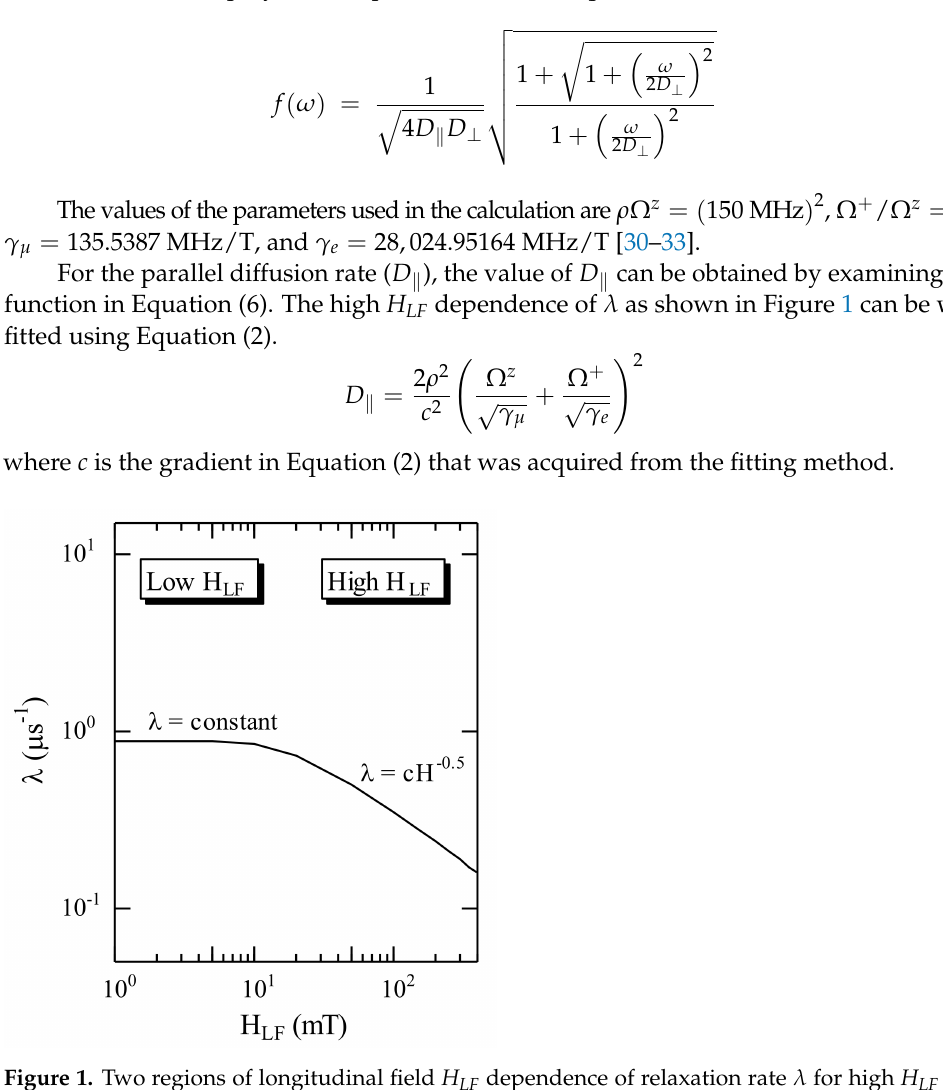
Figure 1. Two regions of longitudinal field H LF dependence of relaxation rate λ for high H LF and low H LF